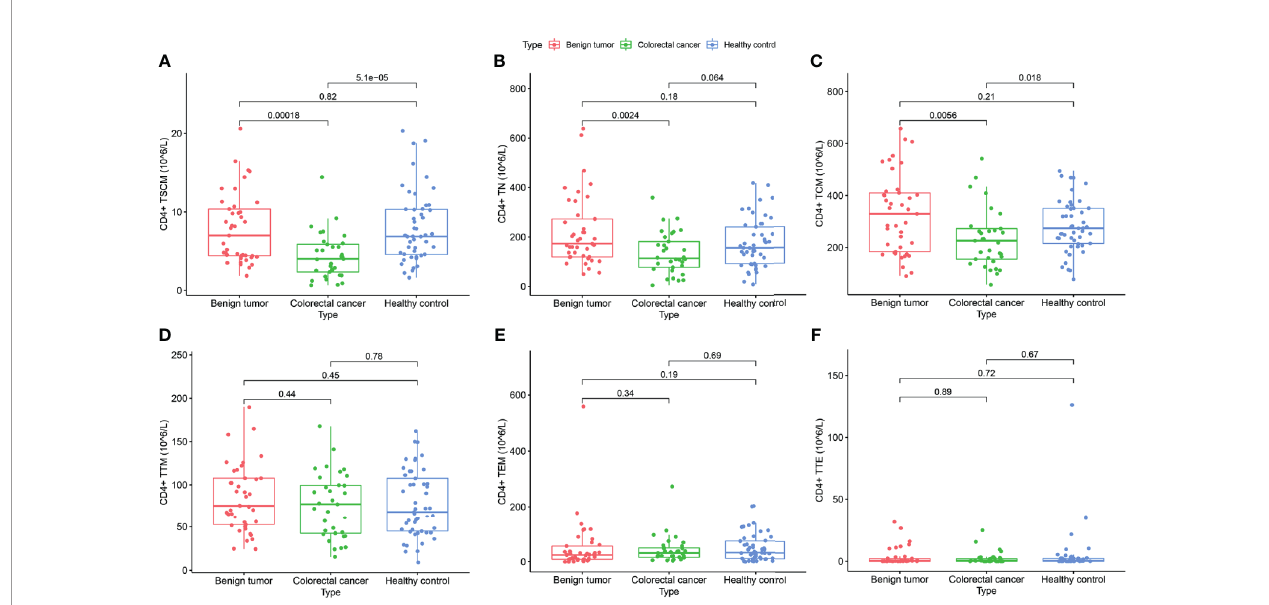
FIGURE 2 | Differences in the absolute value of CD4 + lymphocyte subsets among subjects in the colorectal cancer, benign tumor, and healthy control groups. (A) CD4 + TSCM (10 5 /L); (B) CD4 + TN (10 5 /L); (C) CD4 + TCM (10 5 /L); (D) CD4 + TTM (10 5 /L); (E) CD4 + TEM (10 5 /L); (F) CD4 + TTE (10 5